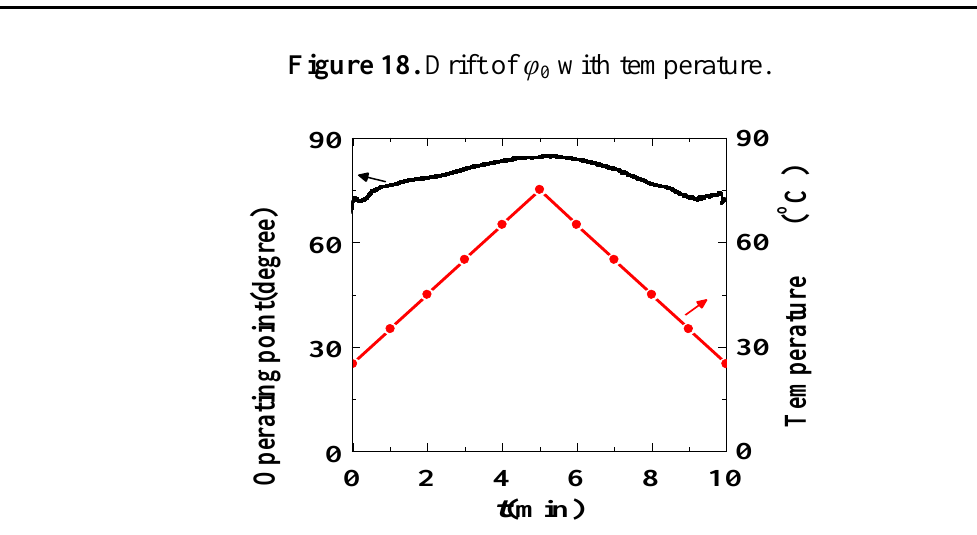
Figure 18. Drift of φ